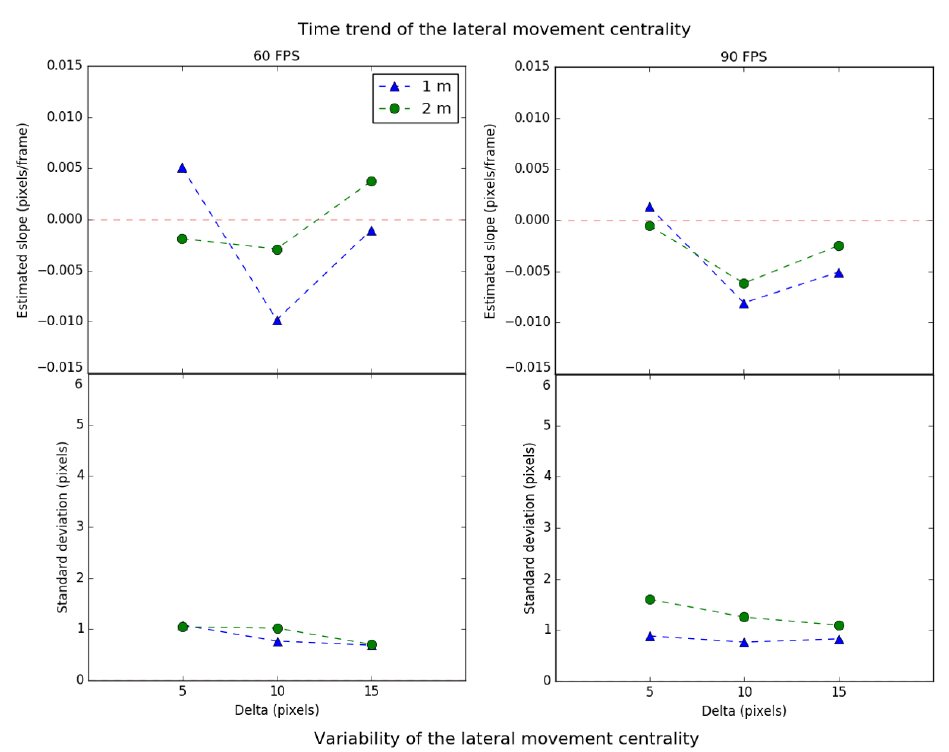
Figure 10. Time trend and variability of the centrality for lateral